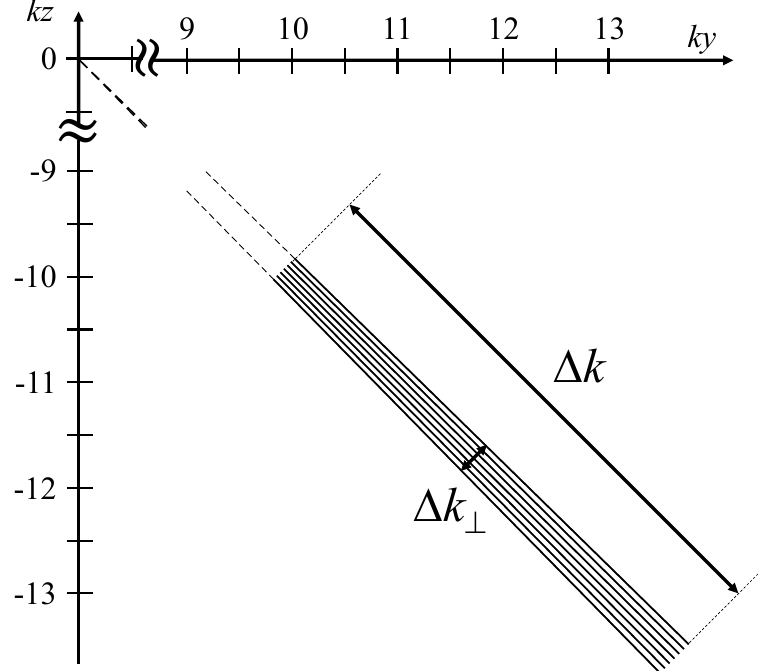
Figure 3. Geometrical loci associated with the wavenumbers illuminated by a tomographic SAR survey for a single target in the { ky , kz } domain; each segment being associated with a different image of the tomographic stack. The spectral extension shown as ∆ k is proportional to the resolution in the range direction and is not improved by processing several images together. On the contrary, the slightly different off-nadir angle associated with each acquisition provides bandwidth along the perpendicular direction, here shown as ∆ k ⊥ . This finite extent is related to the resolution capability of a TomoSAR system along the cross range direction ζ shown in Figure